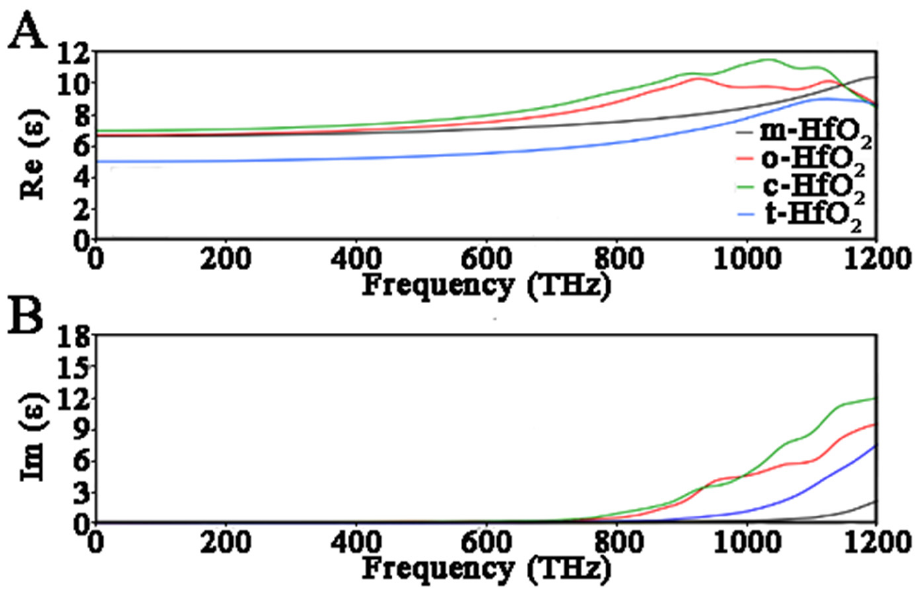
Figure 5. Real part ε 1 ( A ) and imaginary part ε 2 ( B ) of dielectric function for HfO 2 in function of frequency. These data have been obtained using the GGA-PBE approach.